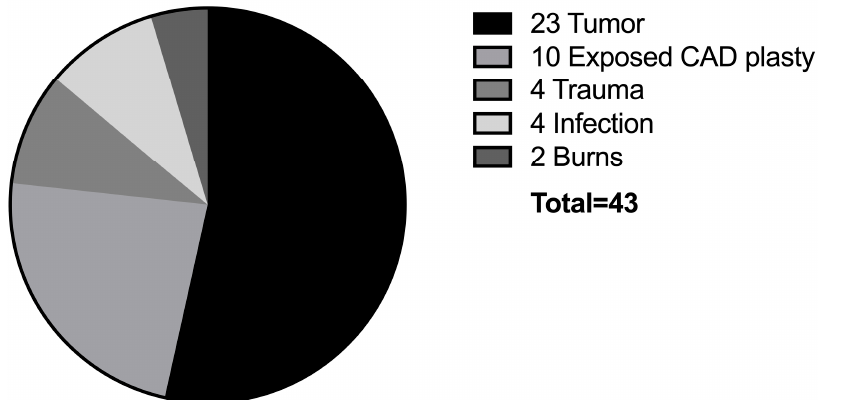
Figure 1. This diagram shows the defect etiology in all 43 cases of scalp reconstruction. CAD: Com- puter-assisted design.